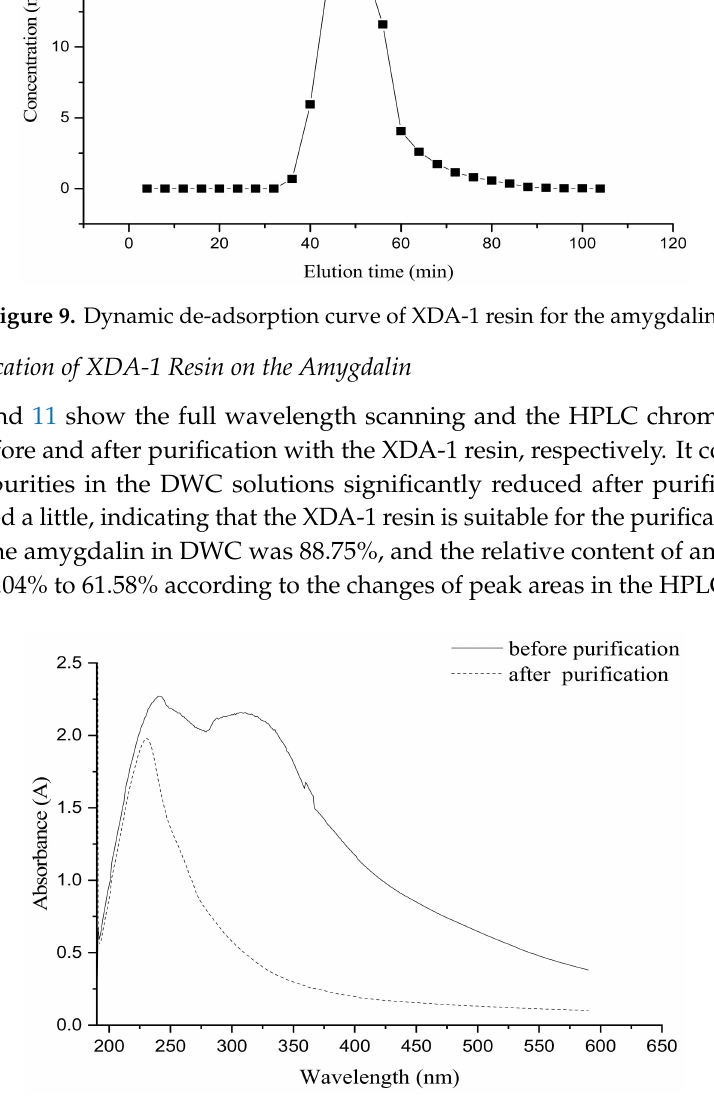
Figure 10. Full wavelength scanning of samples before and after purification by XDA-1